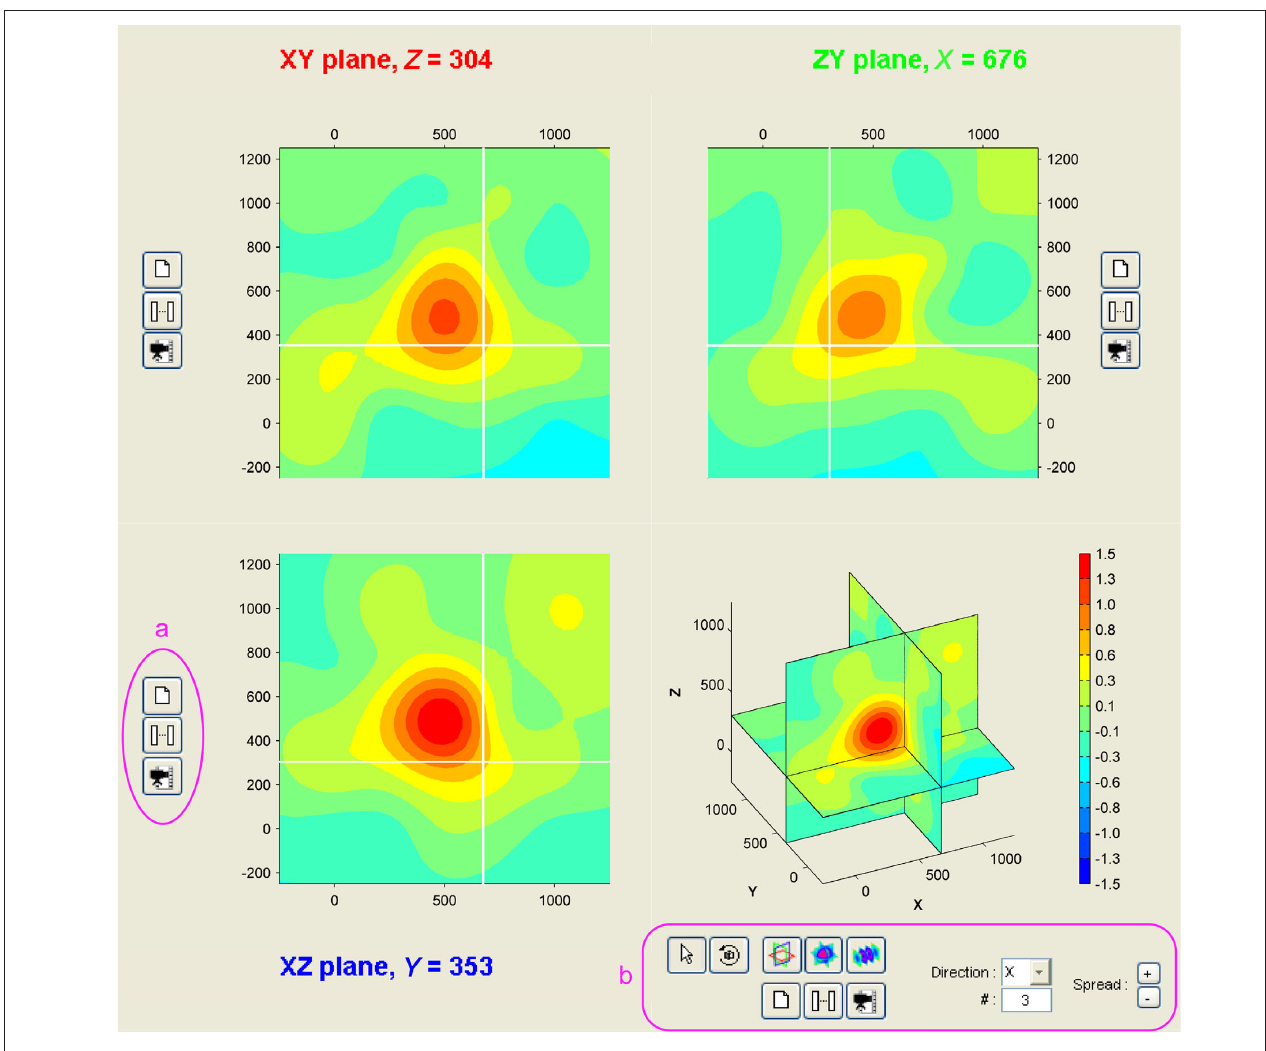
the three views. The interface also includes a volume view (bottom-right) . To each view is associated a set of controls (a) for printing, temporal mapping, and video making. Extra controls (b) come with the volume view to modify the volume display mode: orthogonal slices (as shown here) or parallel slices; in the latter, direction and number of slices can be freely